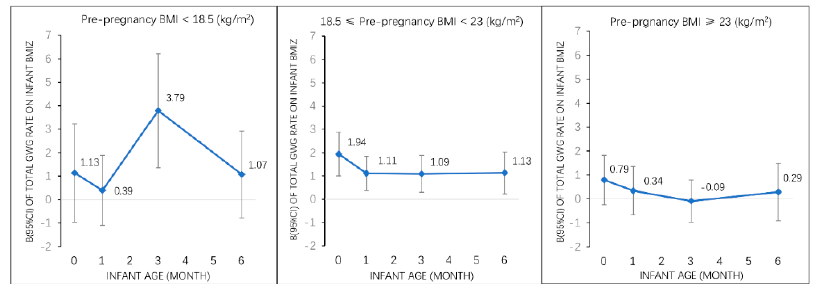
Figure 1. Associations of total GWG rate with infant BMI z-score ( β , 95% CI) from birth to 6 months among all participants and by pre-pregnancy weight status. Adjusted for maternal pre-pregnancy BMI, maternal age, race, parity, education, household income, smoking status, paternal BMI. Abbreviations: GWG, gestational weight gain; BMI z-score, body mass index-for-age z-score; BMI, body mass index; CI, confidence